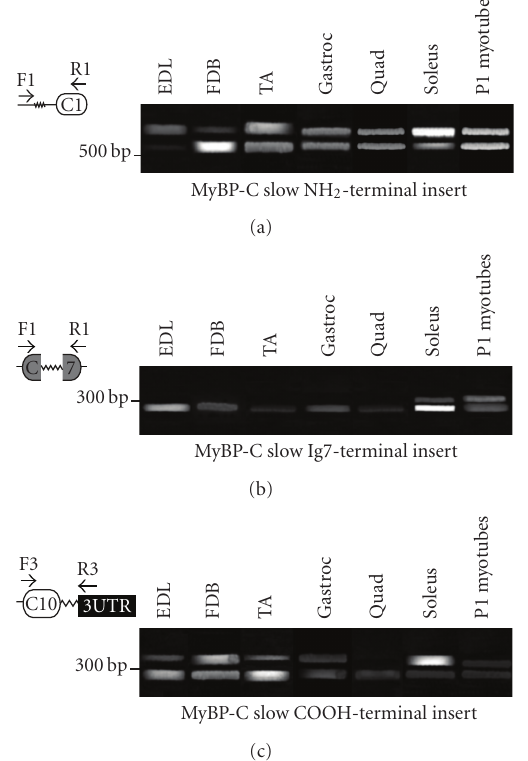
Figure 2: RT-PCR analysis using cDNA generated from developing and adult rat extensor digitorum longus (EDL), flexor digitorum brevis (FDB), tibialis anterior (TA), gastrocnemius (gastroc), quadriceps (quad) and soleus skeletal muscles and primer sets designed to flank the NH 2 -terminal (a), Ig7 (b), and COOH- terminal (c) insertions. A schematic representation of the amplified region is shown in the upper left corner of each panel. White and grey ovals depict Ig and FN-III domains, respectively, while the 3 (cid:3) UTR is shown as a black line. The zig-zag lines denote the three novel insertions. In each amplification reaction, the top band corresponds to transcripts that include the insertion of interest, whereas the bottom band corresponds to transcripts that lack it. (a): All skeletal muscles tested contain a mixed population of MyBP-C slow variants that contain and lack the NH 2 -terminal insertion, as indicated by the presence of two amplification products. (b): On the contrary, only soleus and developing myotubes express transcripts that include the Ig7 insertion. (c): With the exception of quadriceps muscle that only contains MyBP-C slow variants that lack the COOH-terminal insertion, all other muscles examined contain a mixed pool of transcripts that carry and lack the novel COOH- terminal insertion.